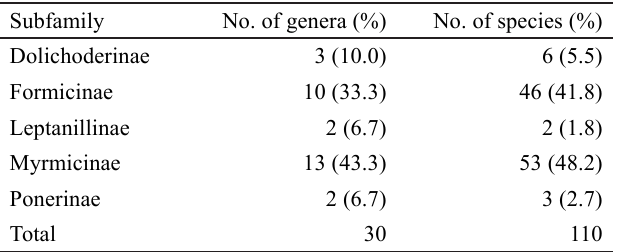
Table 2 . The composition of the ant fauna of the Segura River Basin, with species and genus numbers/percentages given for each